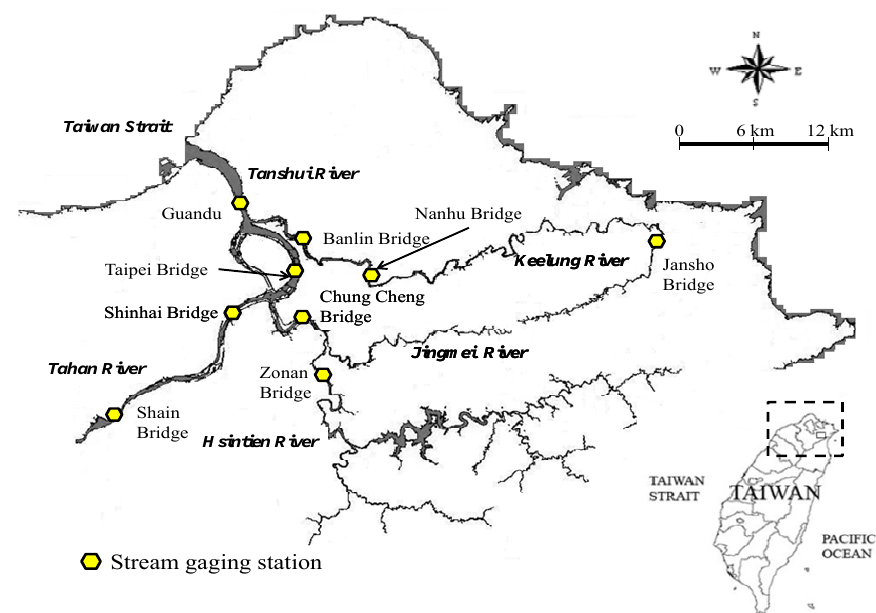
Figure 4. Map of study